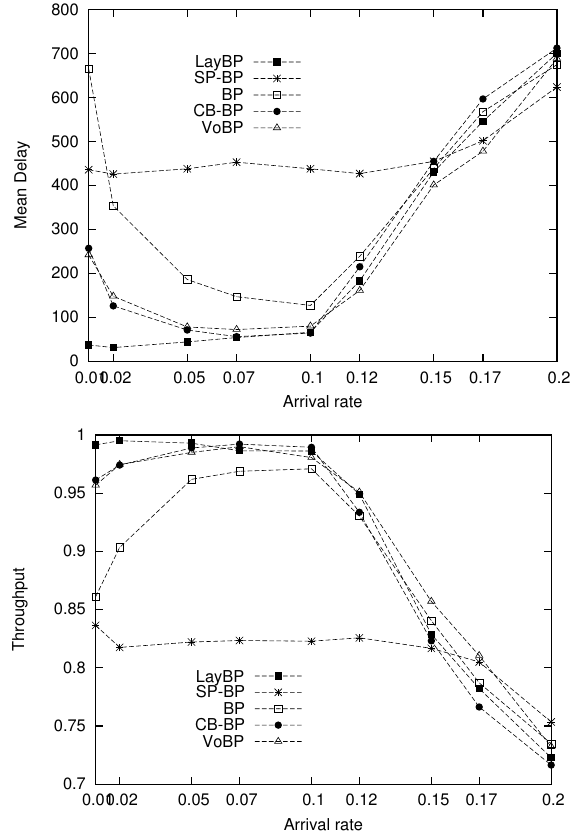
Figure 10. Impact of topology changes on the delay and throughput performance of SP−BP and L ay BP .